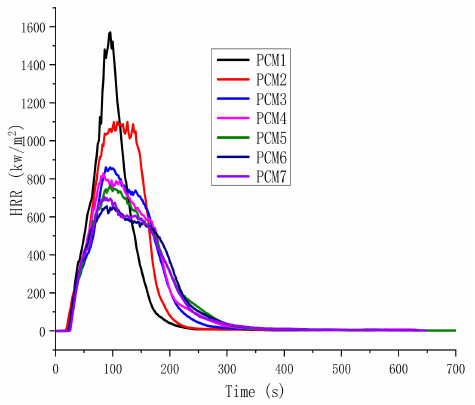
Figure 7. Heat release rate (HRR) curves of the